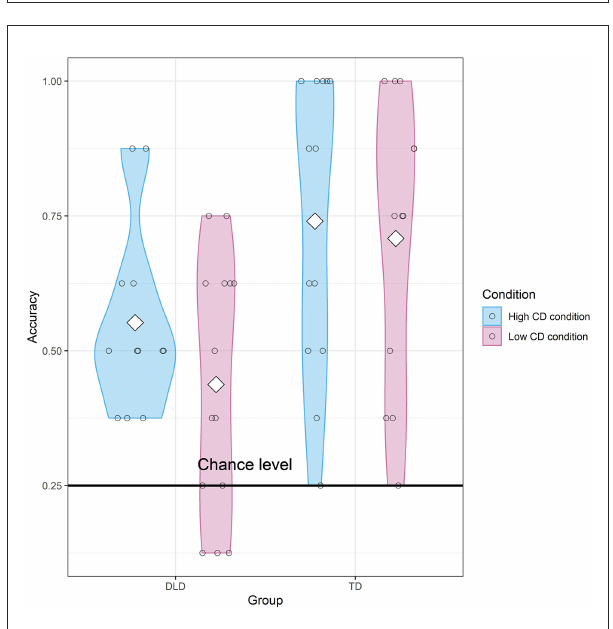
FIGURE4 Accuracy on the off-line test phase per Group and